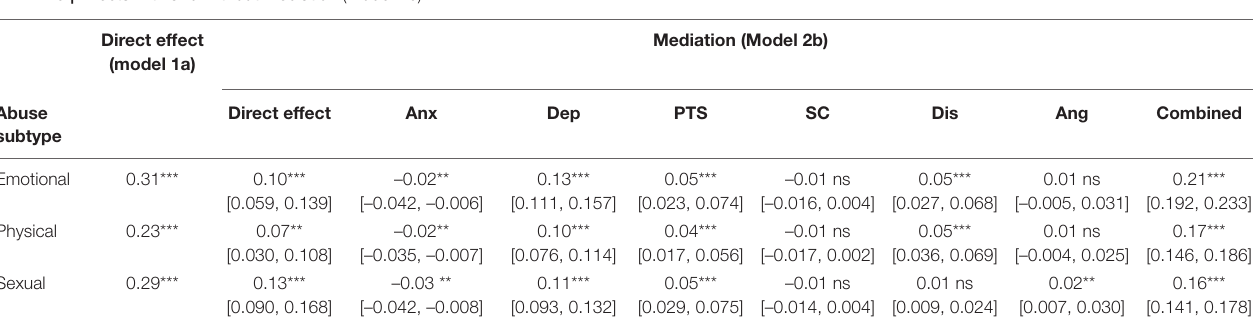
FIGURE 3 | Model 2b: Sub-factors of TSCC as mediators of the relationship between childhood abuse and NSSI. TABLE 6 | Effects with and without mediation (model